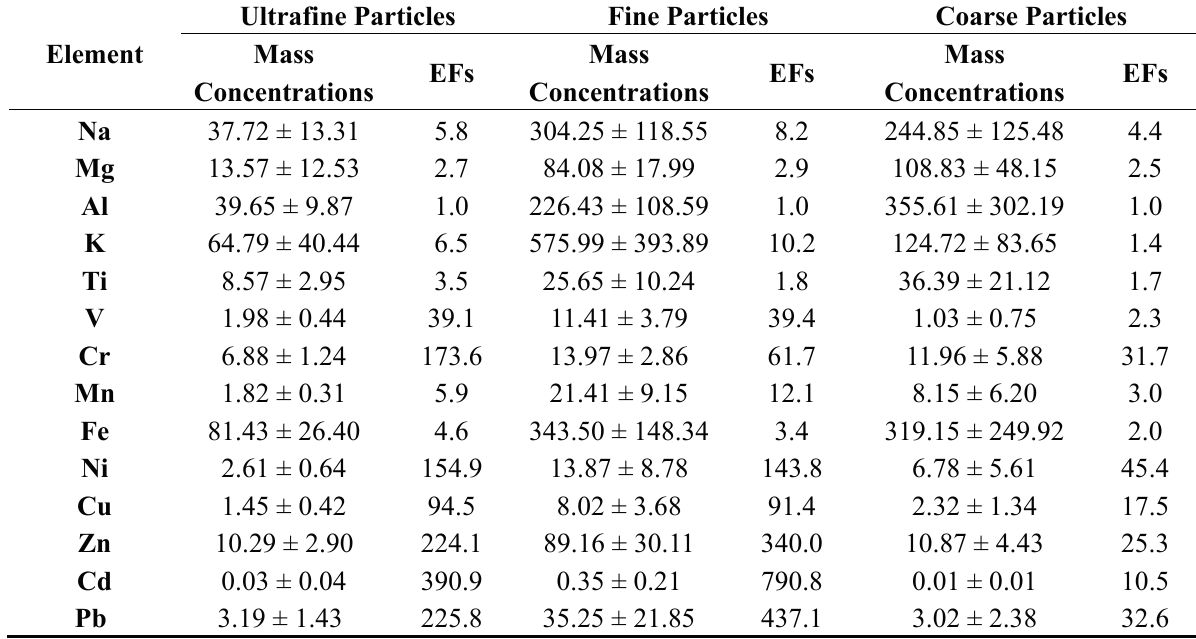
Table 1. Average (± standard error) mass concentrations (ng/m 3 ) and EFs of metallic elements in ultrafine, fine, coarse